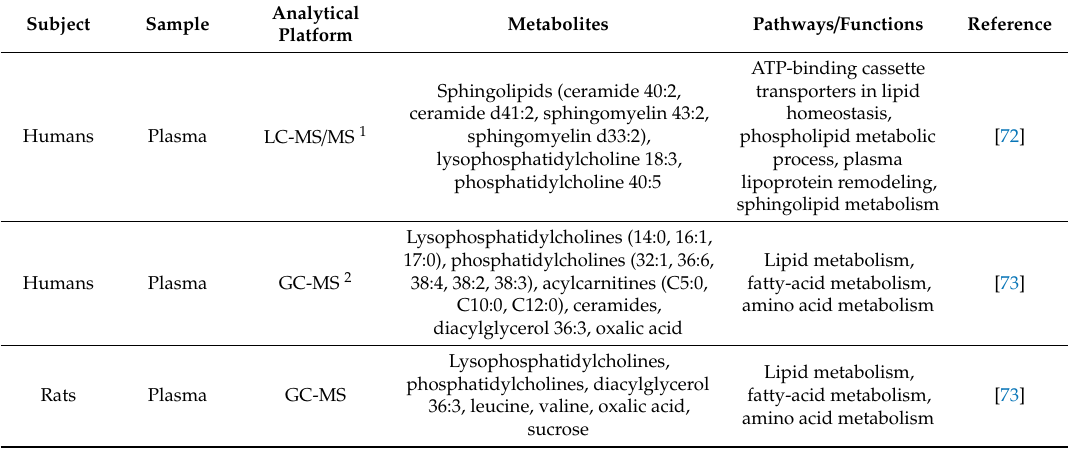
Table 3. Possible biomarkers identified in sleep restricted